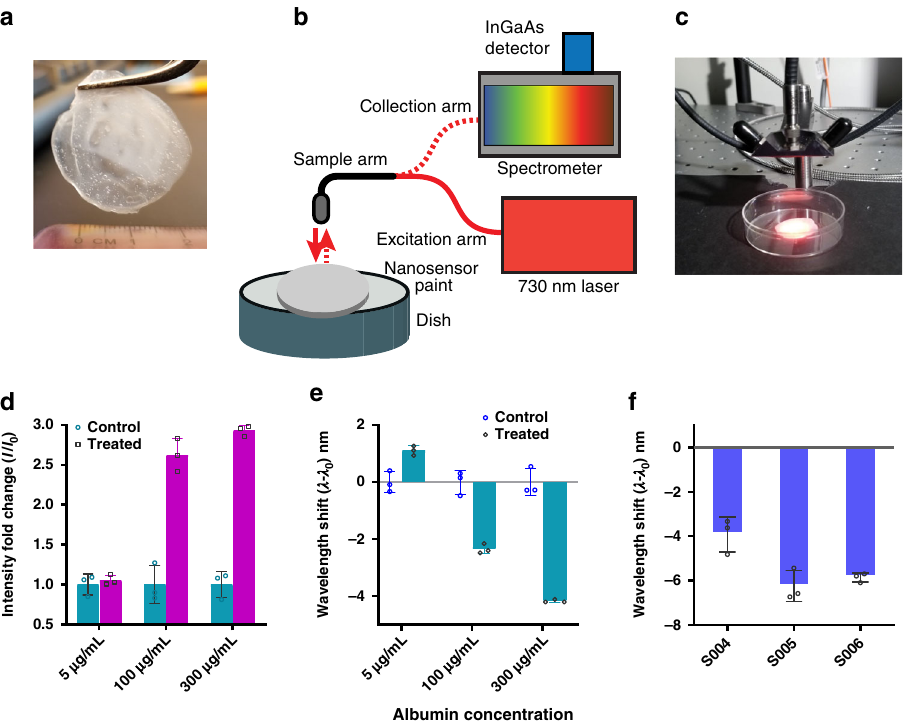
Fig. 4 Albumin detection using free-standing nanosensor paint. a Nanotube blended with acrylic-based paint forming a free-standing fi lm. b Schematic showing probe-based system used to excite nanotubes and collect NIR emission. c Photograph showing data acquisition using the probe-based system. d Emission intensity response of the nanosensor paint to albumin. e Emission wavelength response of the nanosensor paint to albumin. f Nanosensor paint response from microalbuminuria patient ’ s urine samples (S004, S005, and S006). The data in panels d – f show the response of the (9, 4) nanotube chirality. Error bars represent standard deviation for n = 3 technical